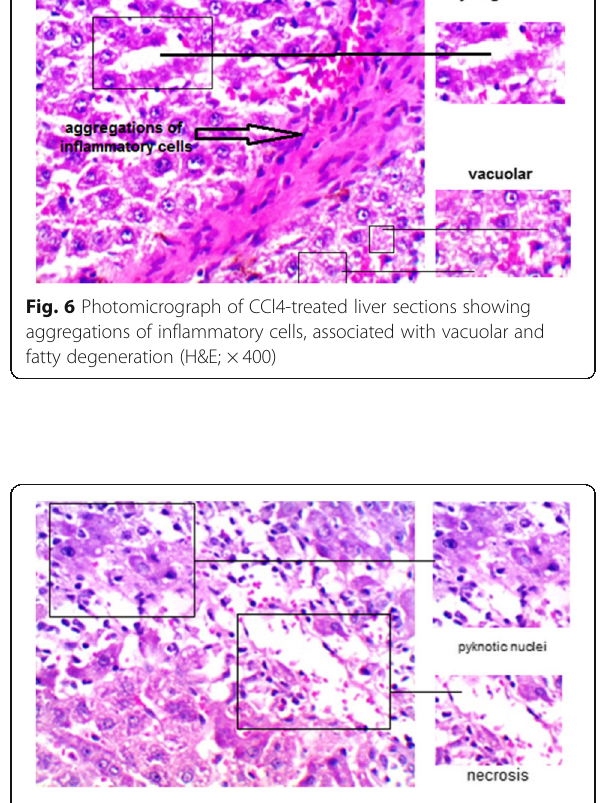
Fig. 4 Photomicrograph of CCl4-treated liver sections showing vacuolated cytoplasm and congestion and dilation of blood vessels (H&E; ×400)